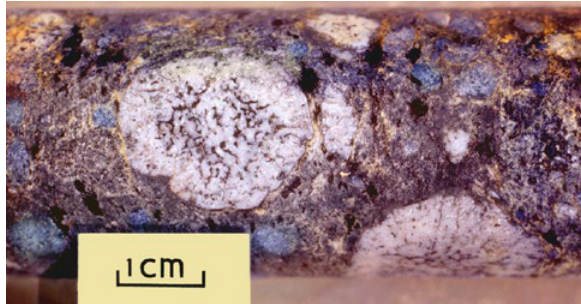
Figure 69. Syneresis shrinkage patterns in Tennant Creek coarse porphyroids have associated orebodies.